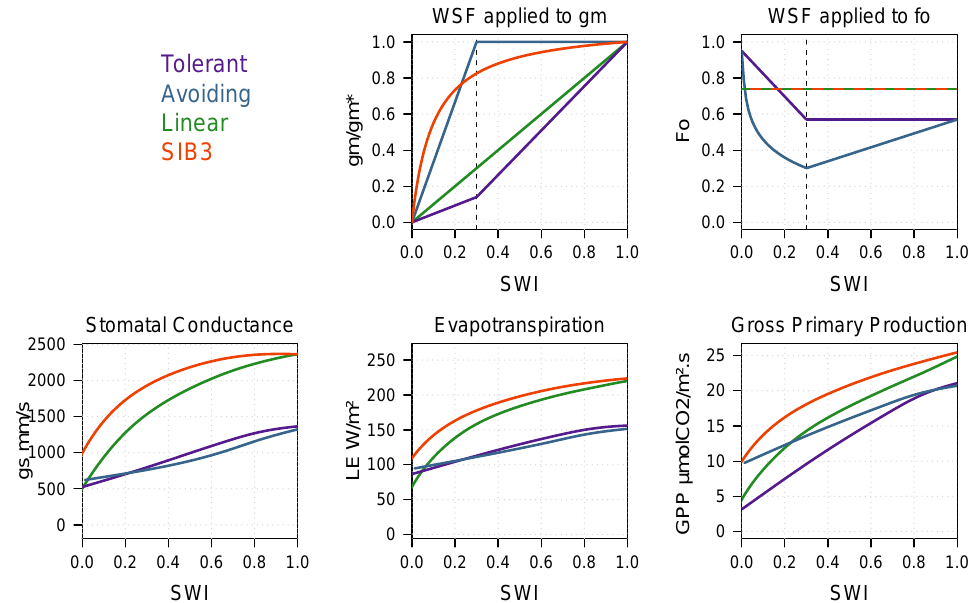
Figure 1. Graphical representation the mesophyll conductance ( g m ) ,the coupling factor at saturating air humidity ( f 0 ) , the stomatal conduc- Figure 1 – Graphical representation the mesophyll conductance (gm),the coupling factor at saturating air humidity ( f 0 ), tance ( g s ) , the evapotranspiration (LE) and the gross primary production (GPP) for the four water stress functions (WSF) used in this study the stomatal conductance (gs), the evapotranspiration (LE) and the Gross Primary Production (GPP) for the four Water against the soil wetness index Stress Functions (WSF) used in this study against the Soil Wetness Index (SWI).